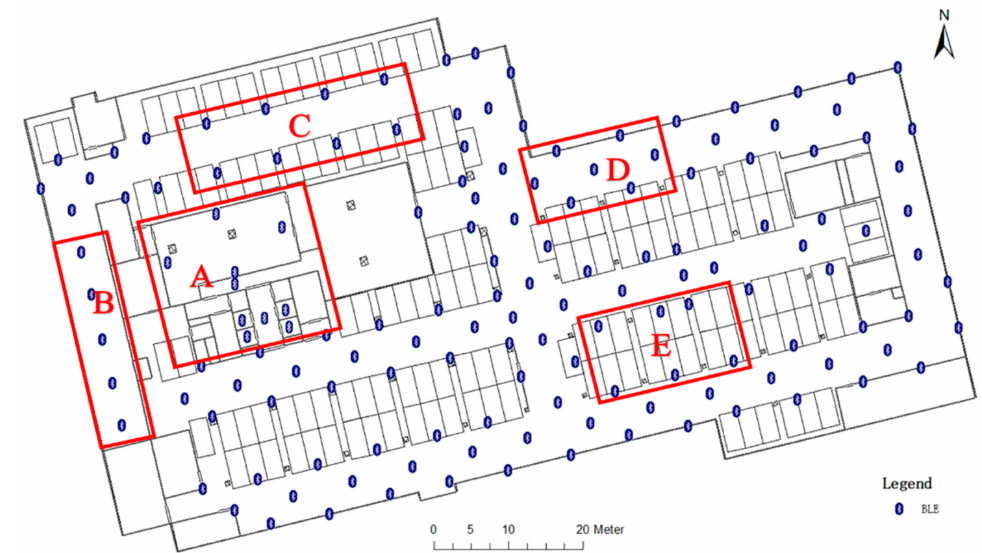
Figure 1. Deployment of BLE beacons with different densities and spatial layouts in underground parking lots: Area-A is the deployment of rooms and elevators, Area-B is a straight-line deployment for the tunnel, Area-C is deployed on two pillars, Area-D is a cross deployment on both sides of the road, and Area-E is a symmetrical deployment above the parking